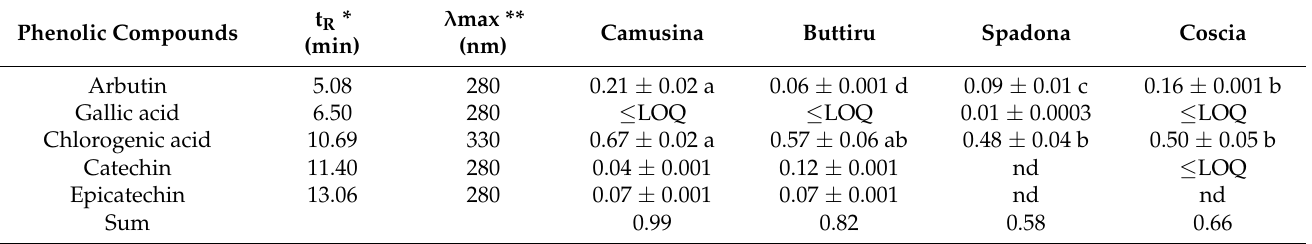
Table 5. HPLC analysis of individual phenolic compounds (mg g − 1 DM) in the fruit flesh of the investigated pear cultivars.